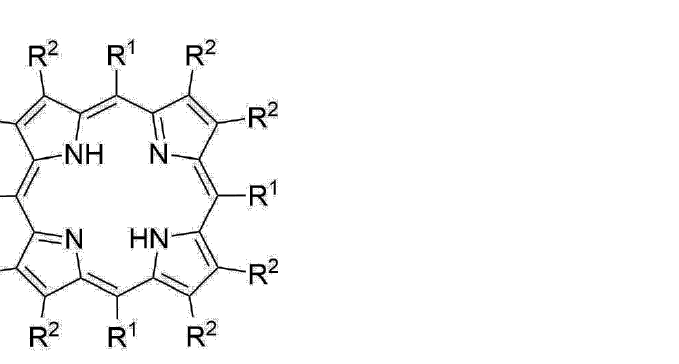
Bicyclo[1.1.1]pentane-1,3-di- carboxylate